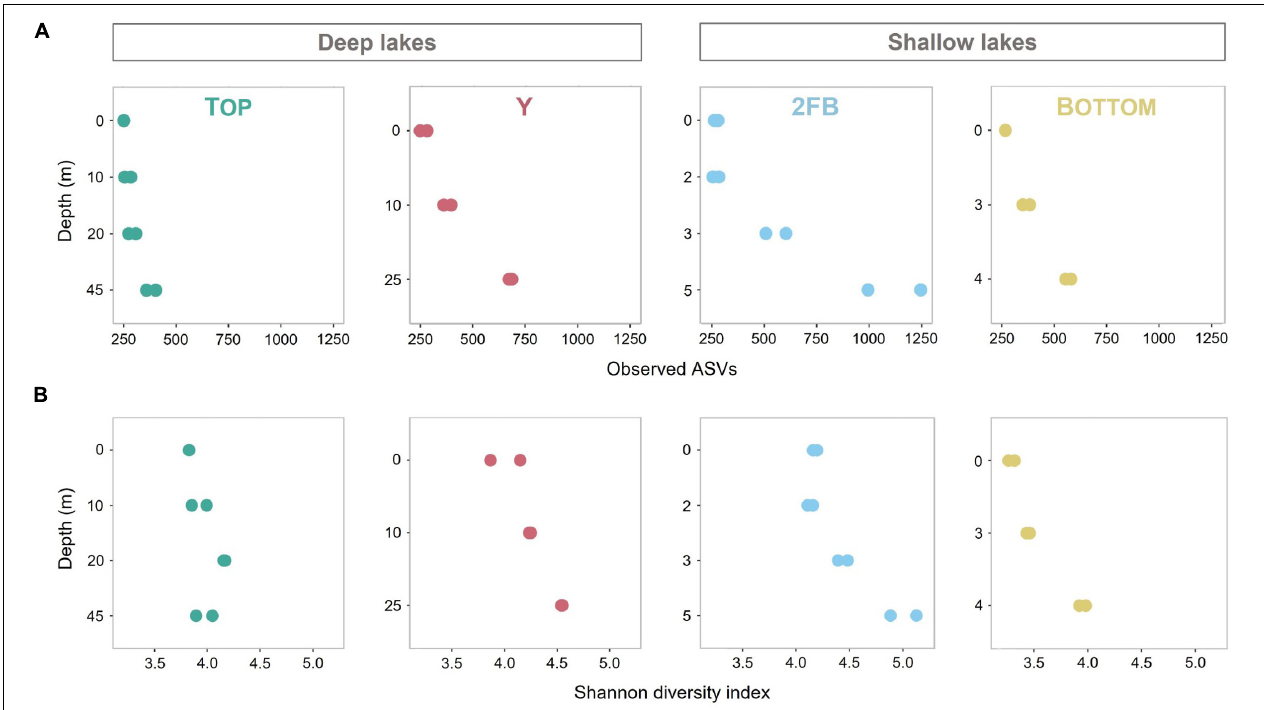
FIGURE 2 | Observed diversity and Shannon diversity in all four Stuckberry Valley lakes. (A) Microbial richness calculated with Observed species index. (B) Microbial richness and evenness calculated with Shannon diversity index. Colors are associated with each lake: turquoise, Top; pink, Y; blue, 2FB; yellow, Bottom. Note that each sample had two replicates (except 0 m in Top Lake) and the changing graduations of the y-axis established according to the maximum depth of the four